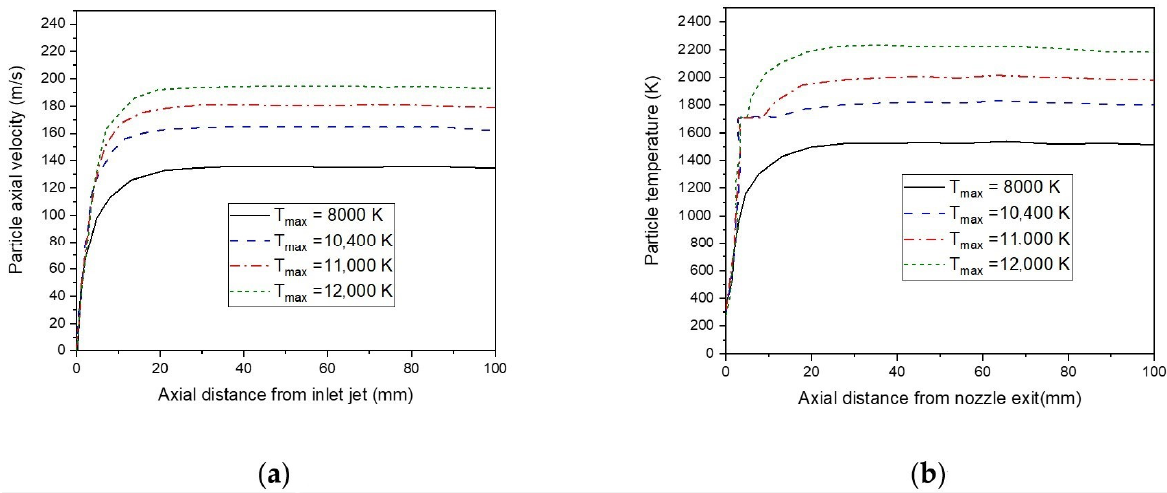
Figure 17. The axial particle velocity ( a ), and the particle temperature ( b ) distributions, under different initial temperatures plasma jet (T max = 8,000, 10,400, 11,000, and 12,000 K). 4.4.5. Particle Turbulent Dispersion Here, the trajectories of the sprayed particles at different intensities of swirl flow (u θ m = 0.3 u zm , u θ m = 0.6 u zm, and u θ m = 0.8 u zm ) are illustrated in Figure 18. Due to random turbulent fluctuation, particles with the same conditions of diameter, injection velocity, and injection time have various paths and temperature histories. Turbulent dispersion widens the particle’s trajectories and heating histories and may hide the effect caused by the jet flow field. Indeed, due to the inlet swirling flow, the temperature and velocity drop along the axial jet axis towards the substrate. Momentum and transferred energy from plasma to particles decrease, defecting the particle’s trajectory away from the plasma jet axis at higher swirl velocity.